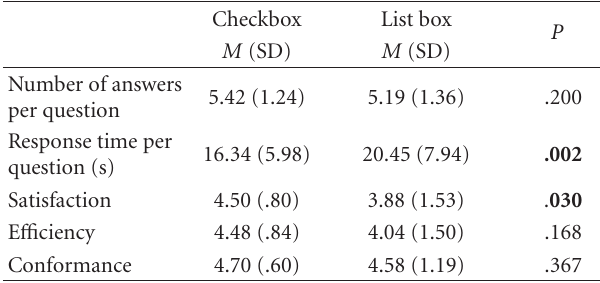
Table 1: Mean and standard deviation of the checkbox and the list box condition.